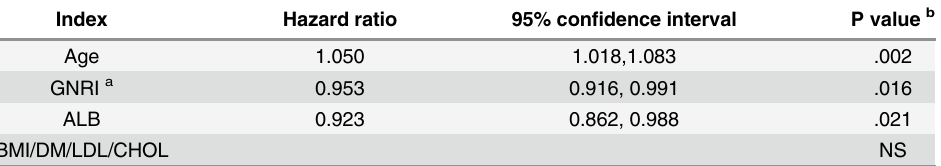
Table 4. Multivariate analysis of factors affecting overall amputation in patients with critical limb